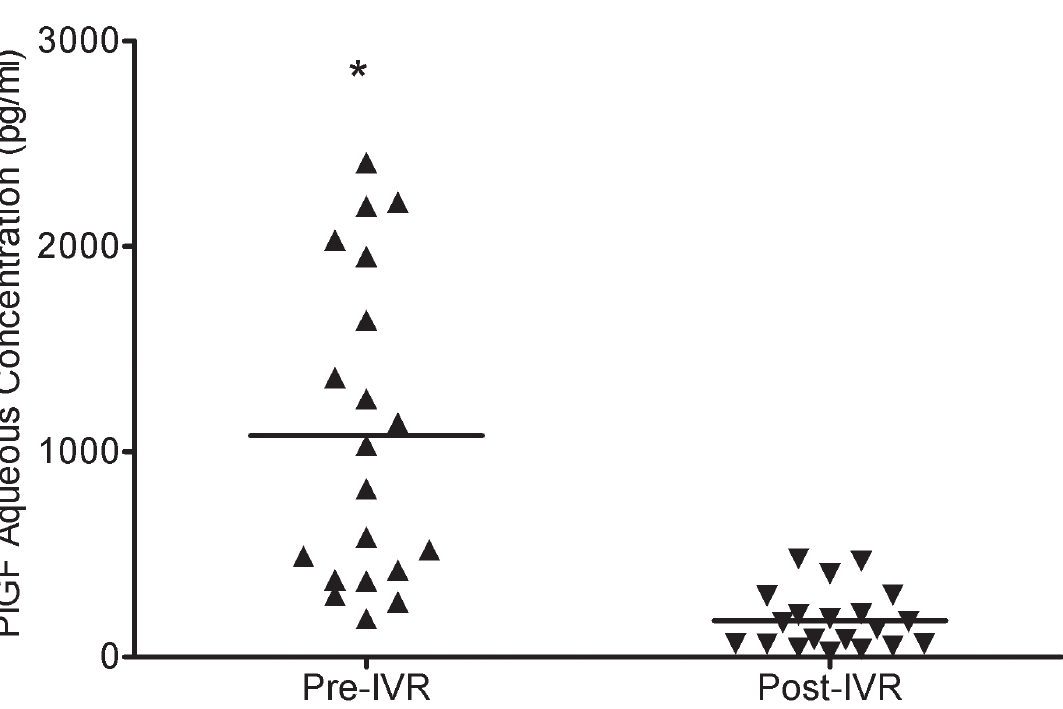
Fig 5. PlGF concentration pre and post-IVR. There were statistically significant differences pre- and post-IVR in the PlGF concentration in the aqueous humor (p < 0.001). Each point represents a measurement from a single patient. doi:10.1371/journal.pone.0146993.g005 PLOS ONE | DOI:10.1371/journal.pone.0146993 January 19,